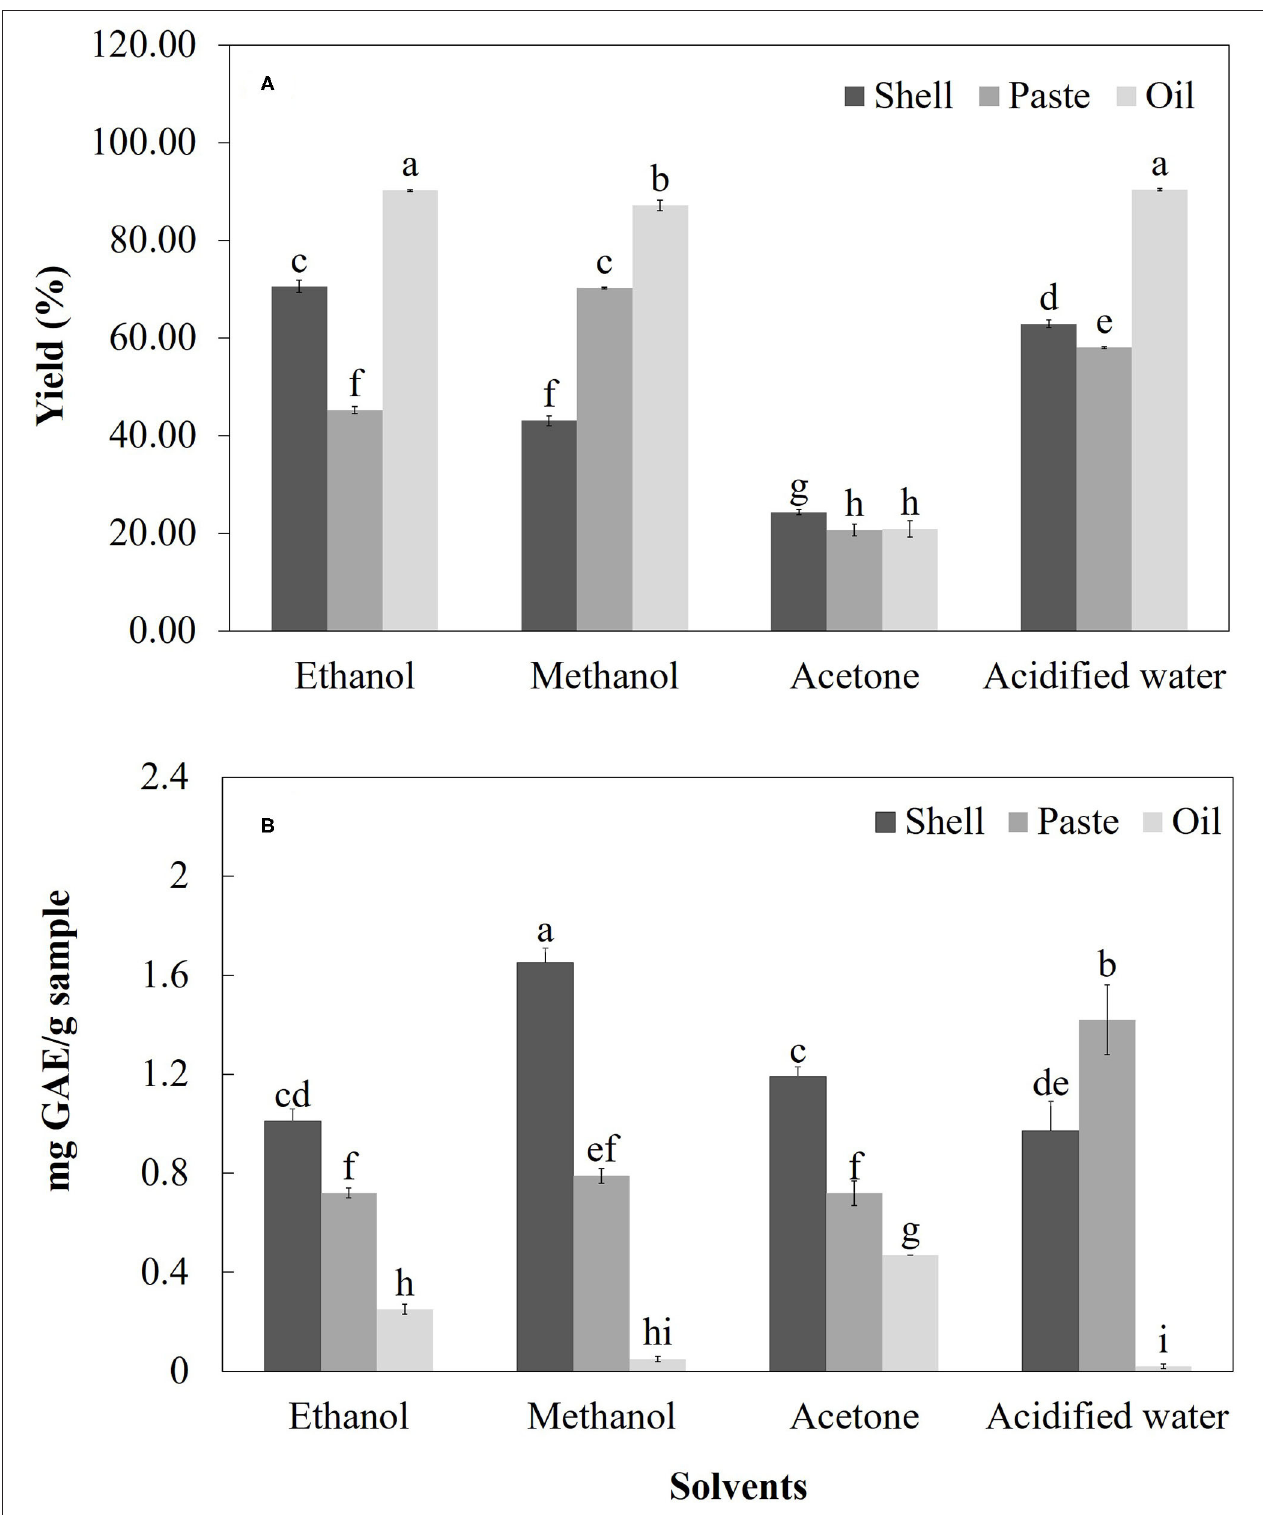
FIGURE 3 | (A) Yields of different solvents and (B) extraction of total phenolics of various almond by-products. The vertical bars indicate mean ± standard deviation ( n = 3).